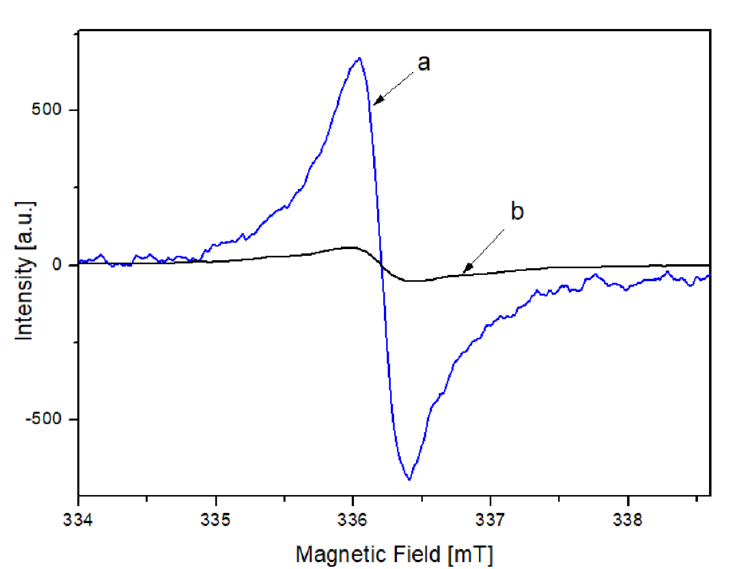
Figure 1. EPR spectra of the HAs extracted from forest soils ( a ) and isolated from incubated samples of plant material ( b ).